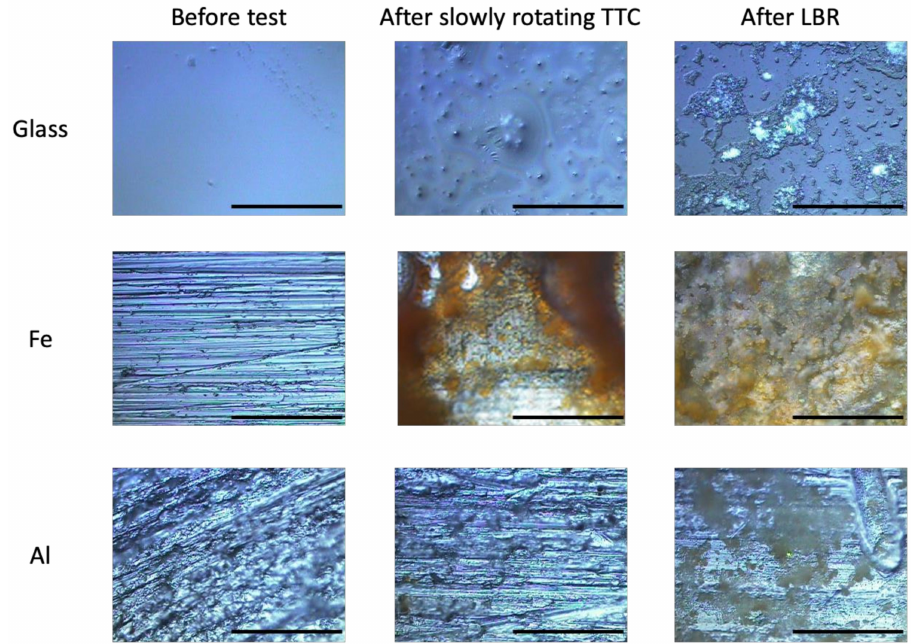
Figure 2. Optical microscopic images of the surface of materials that were analyzed by Raman spectroscopy. These samples were observed under an optical microscope equipped with a Raman spectroscopy apparatus ( × 100). The center of each image indicates the position analyzed by Raman spectroscopy. Al: aluminum; Fe: iron; LBR: laboratory biofilm reactor; and TTC: test-tube culture. Each black bar indicates 20 µ